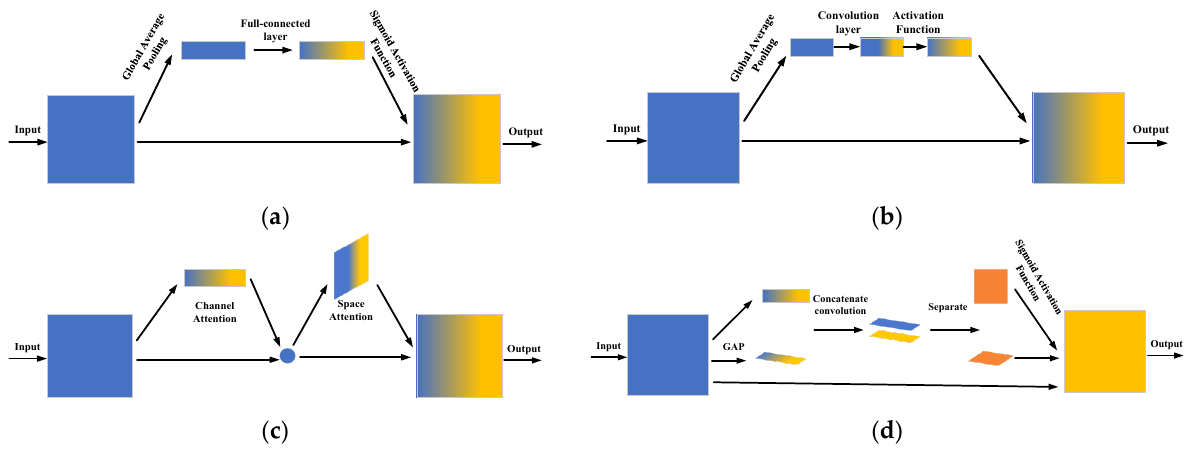
Figure 5. The structure of attention modules: ( a ) SENet; ( b ) ECANet; ( c ) CBAM; ( d ) CoordAtt.